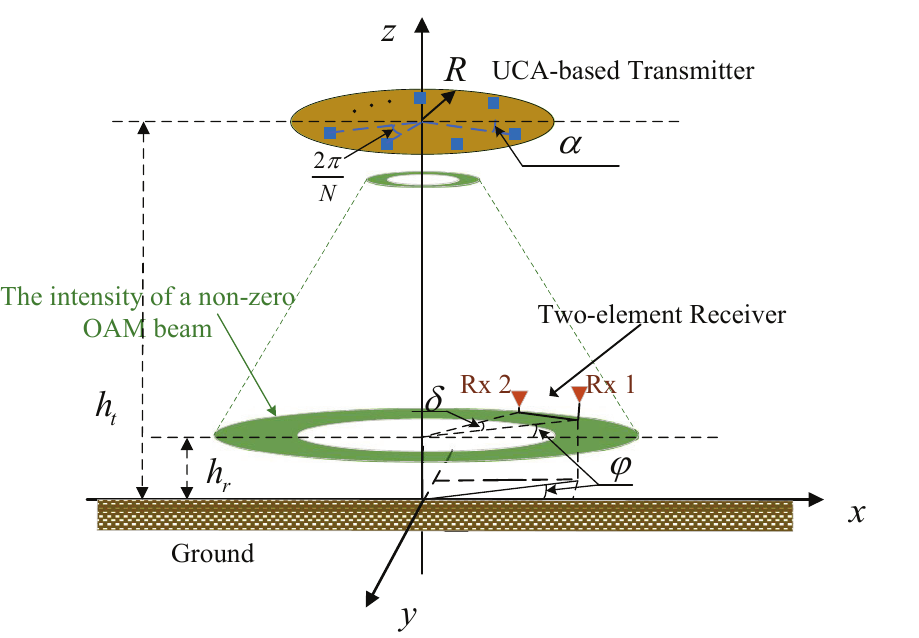
Figure 2. The LOS geometric channel